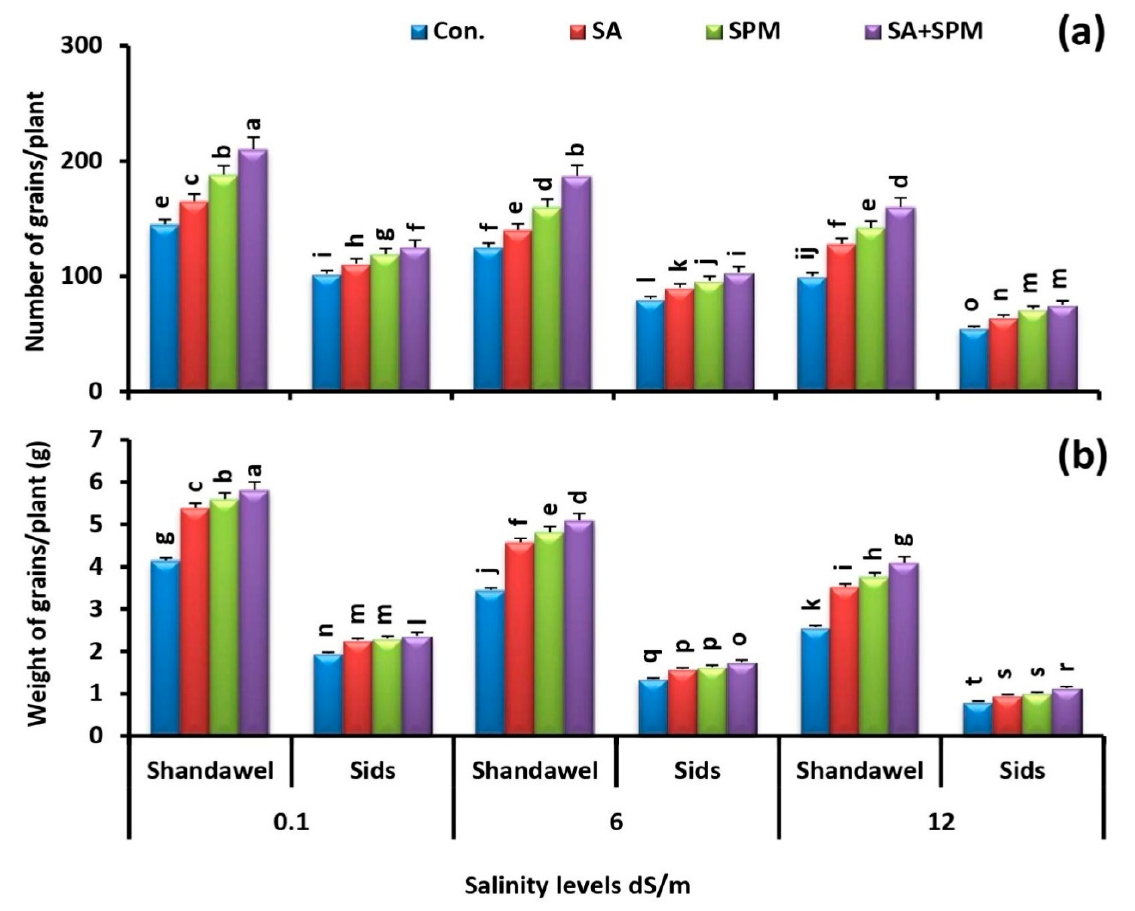
Figure 2. Influence of salicylic acid (SA; 100 mgL − 1 ) and/or spermine (SPM; 30 mgL − 1 ) on the ( a ) number of grains plant − 1 and ( b ) weight of grains plant − 1 of two wheat cultivars (Shandawel 1 and Sids 14) grown under 0.1, 6, and 12 dS m − 1 salinity levels. Data are mean of four replicates (n = 4). Different letters indicate significant differences at ( p < 0.05) level according to Duncan’s test.